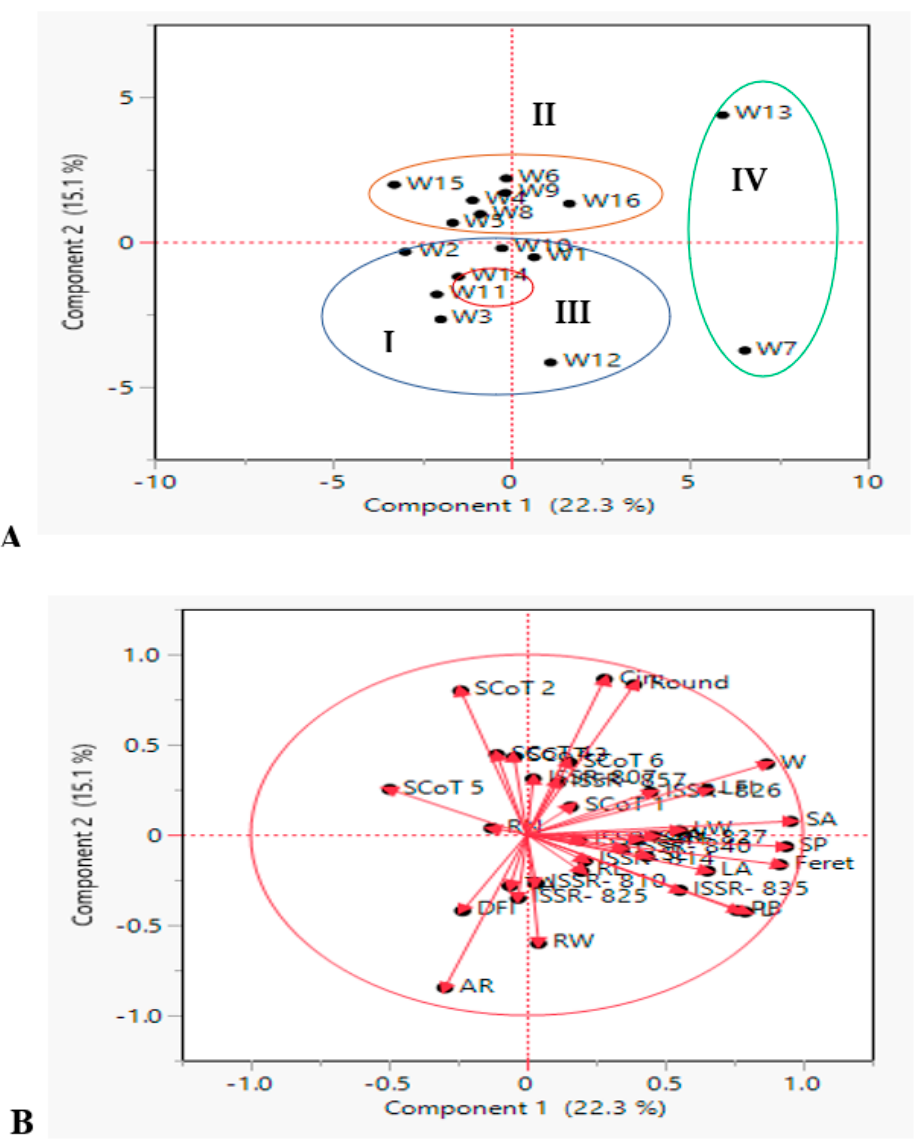
Figure 5. Principal component analysis (PCA) illustrating the genetic diversity expressed by the grouping of 16 Egyptian T. aestivum cultivars based on the analysis of 19 morphometric traits, 10 ISSR and 6 SCoT primers polymorphism ( A ) scatter plot analysis showing four clusters (Cluster I, II, III and IV represent as blue, orange, red and green oval shapes, respectively); ( B ) the interrelationship among all measured morphological and molecular marker parameters. The dots are genotypes and the vectors (red arrows) are parameters.